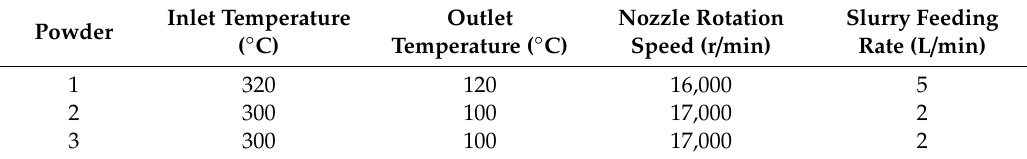
Table 1. Parameters used for spray-drying granulation.